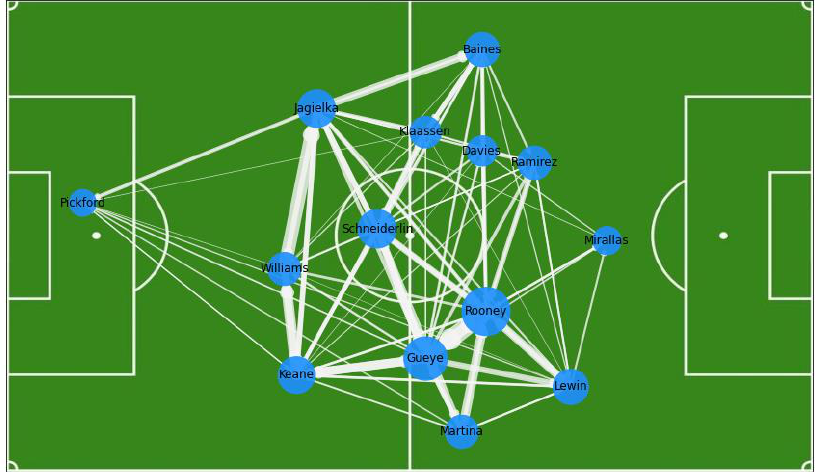
Figure 4. Everton’s passing network in the first round of Premier League .